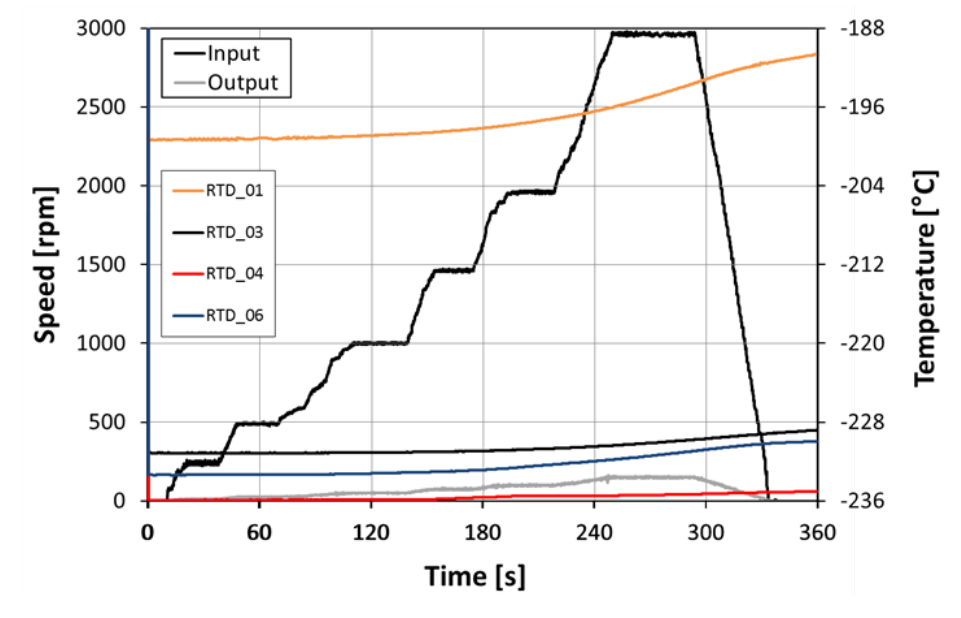
Figure 12. Input and output speed